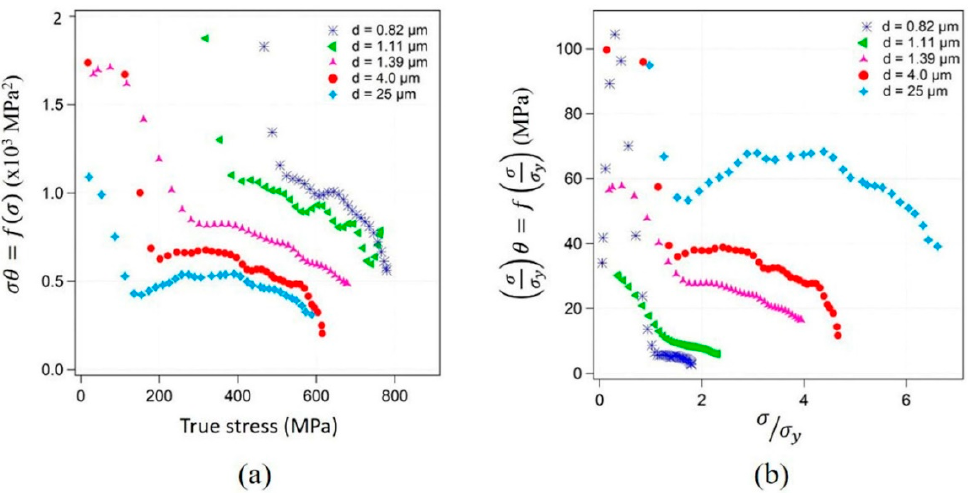
Figure 5. Evolution of the σ · θ product with stress for the Ni samples processed by SPS with different grain sizes ( a ) and the same curves after normalization of stress by yield strength σ y ( b ). The average grain size of the samples is indicated in a color scale for each figure.